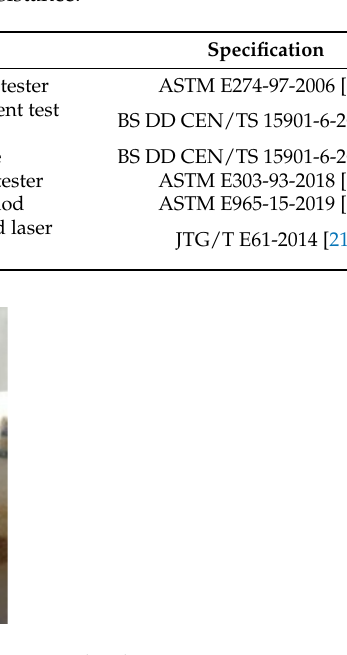
Table 2. Test methods for the characterization of skid resistance.